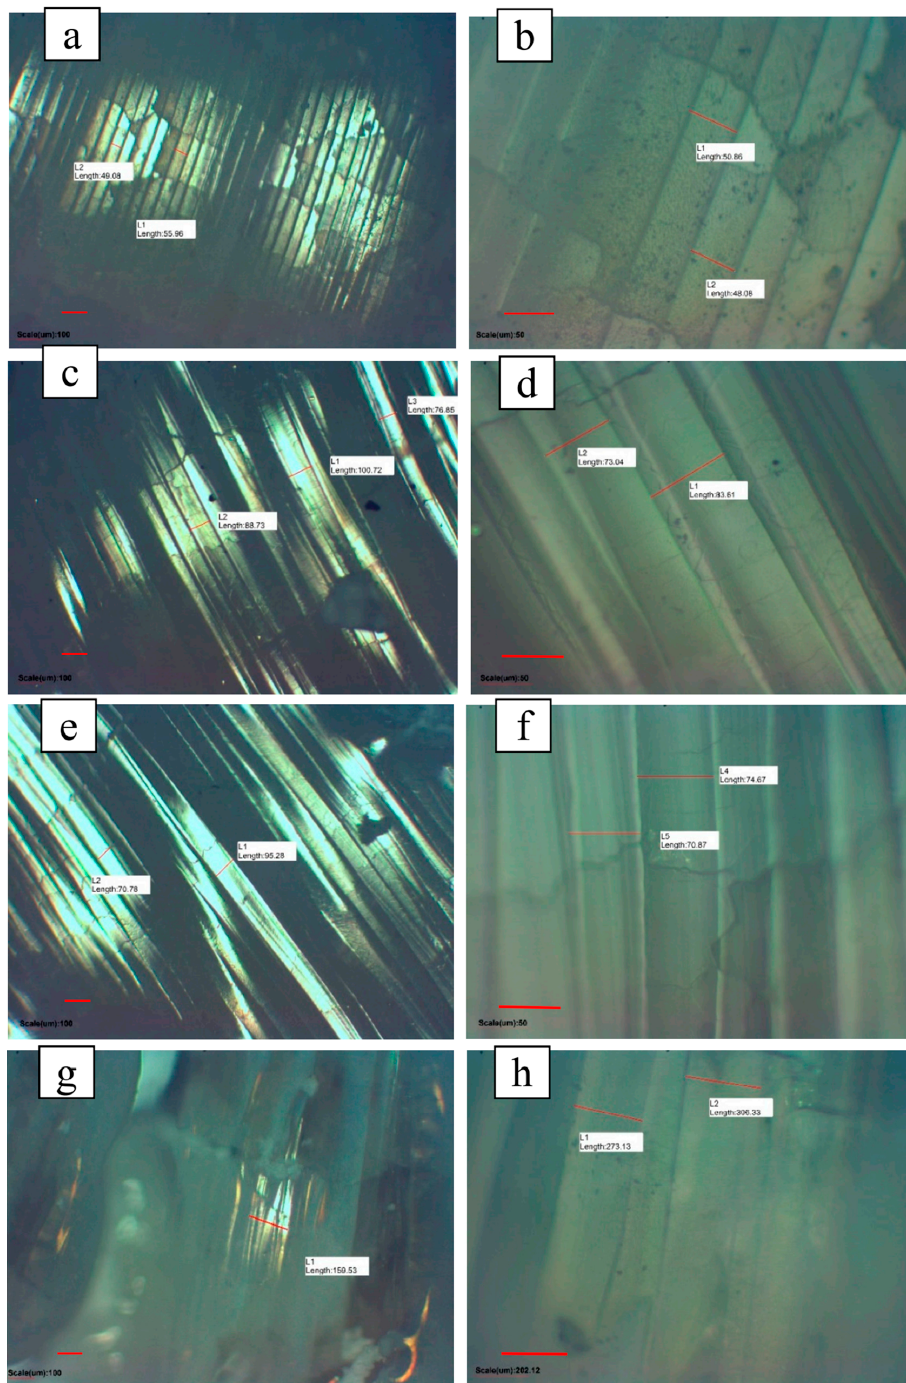
Figure 6. Microscopic images (different scales) of the YSZ layer printed on the Ni–YSZ anode substrates. ( a , b ) Hatching space of 15 µ m, scanning speed of 80 mm/s, and target power of 78 W. ( c , d ) hatching space of 20 µ m, scanning speed of 100 mm/s, and target power of 78 W. ( e , f ) Hatching space of 20 µ m, scanning speed of 80 mm/s, and target power of 78 W. ( g , h ) Hatching space of 25 µ m, scanning speed of 100 mm/s, and target power of 78 W [72].